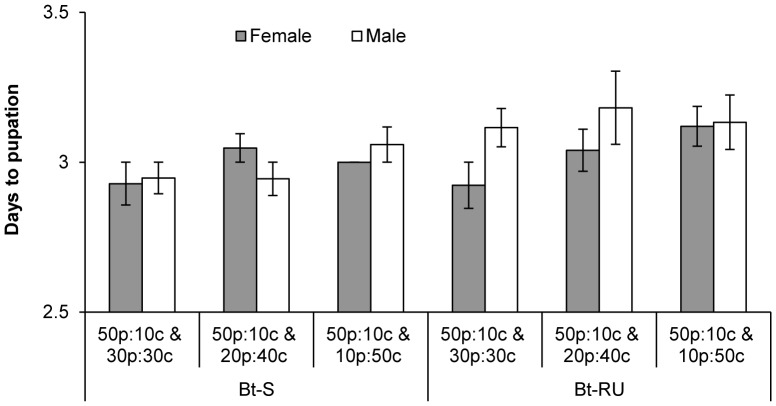
Delayed development accompanies compensatory feeding.Mean number of days (±SE) to initiate pupation in the final instar by Bt-S and Bt-RU.